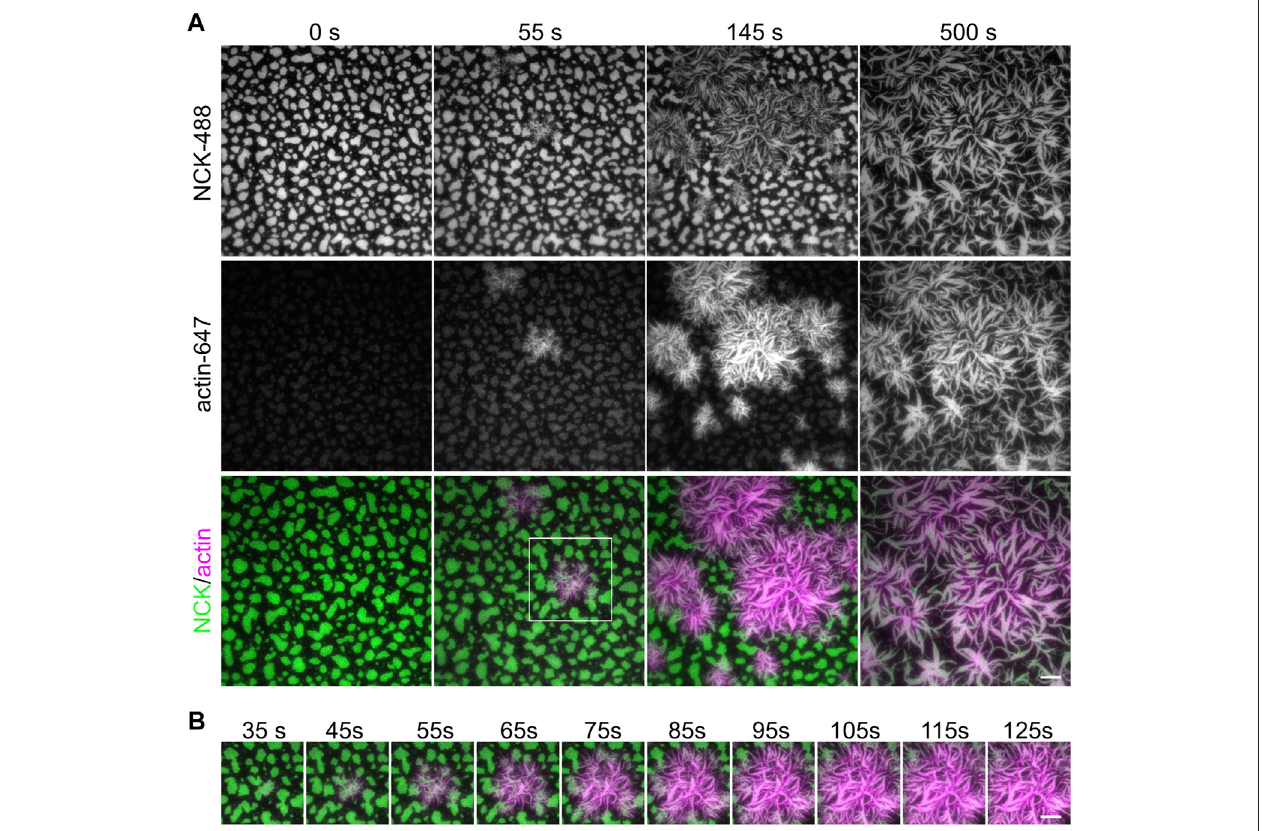
FIGURE 4 | Actin polymerization from phase-separated clusters. (A) Total Internal Re fl ection Fluorescence (TIRF) imaging of 1 µM actin (5% labeled by Alexa647, magenta) polymerization with 3 nM Arp2/3, 0.25 µM ATP, 0.1 mM MgCl 2 and 0.1 mM EGTA, from clusters made from 500 nM Nck (15% labeled by Alexa488, green), 250 nM N-WASP and 2.5 nM His 8 -nephrin on the membrane. (B) Zoom-in view of the region indicated by white box in (A) . Scale bars, 10 µm. Total Internal Re fl ection Fluorescence (TIRF) penetration depth 200 nm for all channels.